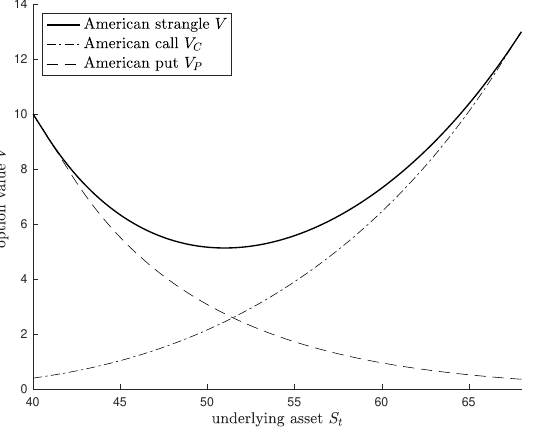
Figure 8. The comparison of the option values with those of the American call and put options,